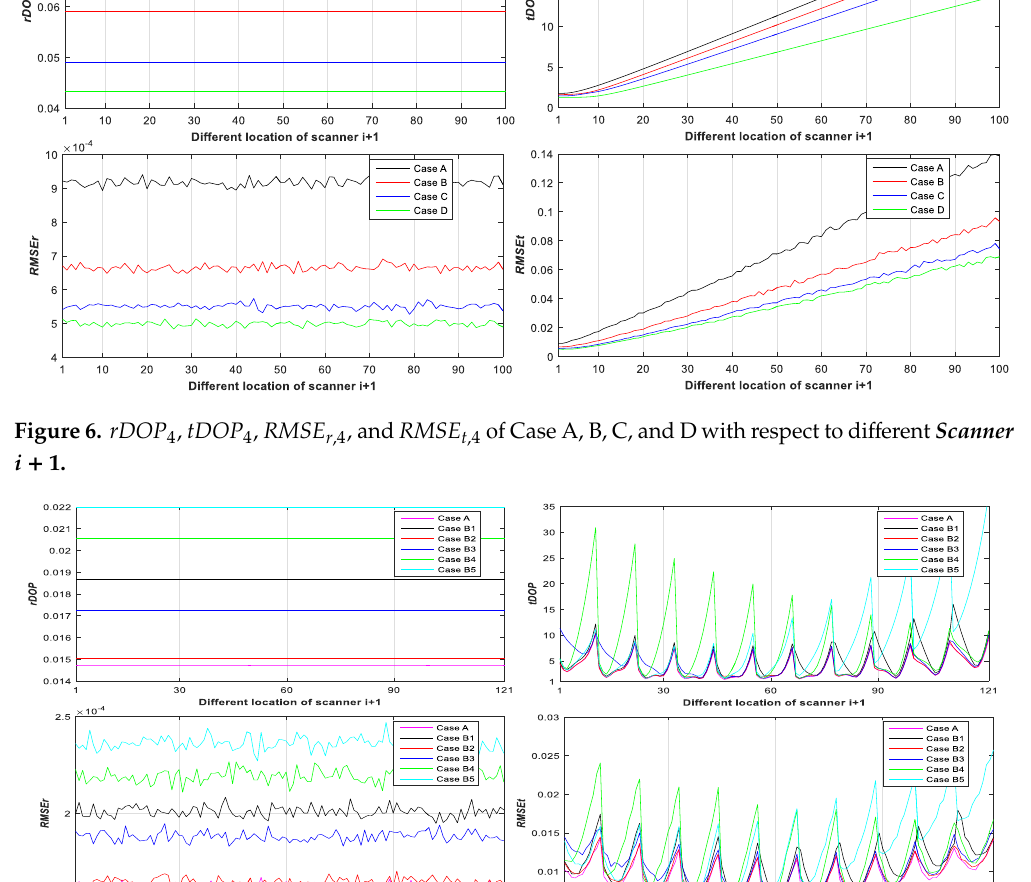
Figure 7. 5 rDOP , 5 tDOP , ,5 r RMSE , and ,5 t RMSE of Case A and B1 – 5 with respect to different Figure 7. rDOP 5 , tDOP 5 , RMSE r ,5 , and RMSE t ,5 of Case A and B1–5 with respect to di ff erent scanner i + scanner i + 1 .